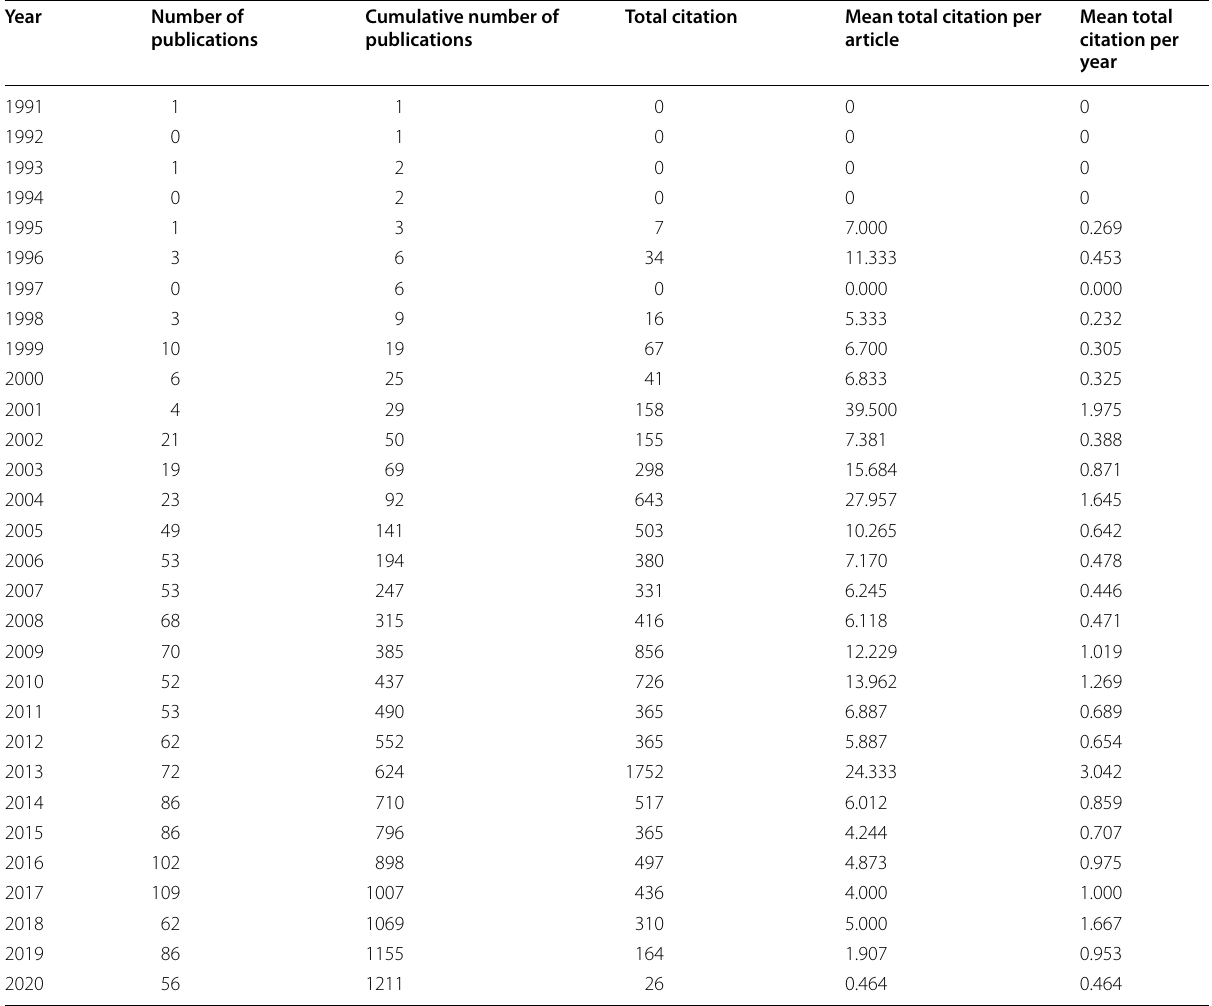
Table 2 Statistics for literature published related to